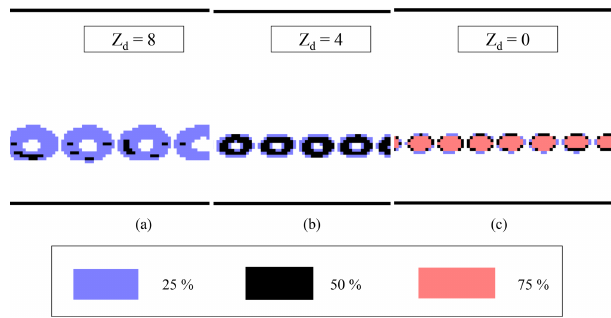
Figure 5. Example images from the CIP-15 of droplets from the droplet generator using a 90µm printhead at Z d = 8 (a) , Z d = 4 (b) and Z d = 0 (c) . Decreases in detector intensity of 25% to 50%, 50% to 75% and >75% are shown as light blue, black and orange pixels, respectively.